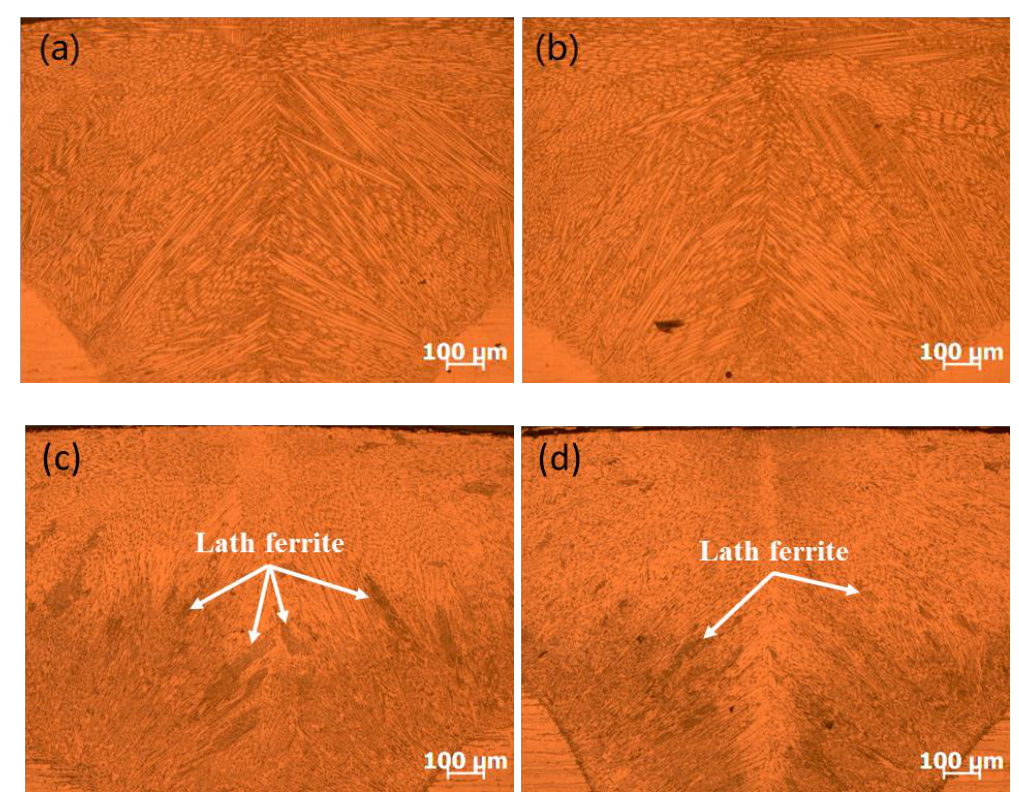
Figure 13. OM image of the microstructure of the cross-section of the weld joint. ( a ) OM image in SUS310 at the welding speed of 1.0 m / min; ( b ) OM image in SUS310 at the welding speed of 2.0 m / min; ( c ) OM image in SUS304 at the welding speed of 1.0 m / min; ( d ) OM image in SUS304 at the welding speed of 2.0 m /